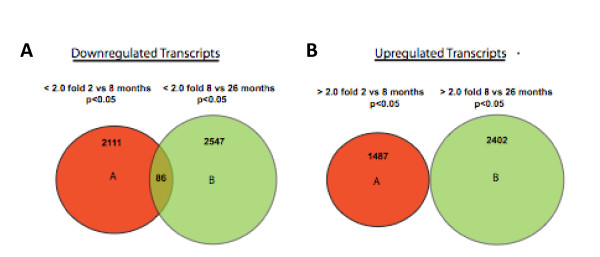
Comparisons of down and up-regulated transcripts.  Venn Diagram illustrating fold gene expression differences between 2m, 8m, and 26m (t-test <2-fold, p<0.01) of 40,359 transcripts. Expression levels of 2111 transcripts decreased from 2m to 8m and 2547 transcripts decreased from 8m to 26m.  Only 86 transcripts commonly decreased over both age groups. Analysis of up-regulated genes in the same manner revealed 1487 transcripts that were increased from 2m to 8m and 2402 increased from 8m to 26m.  There was no overlap.